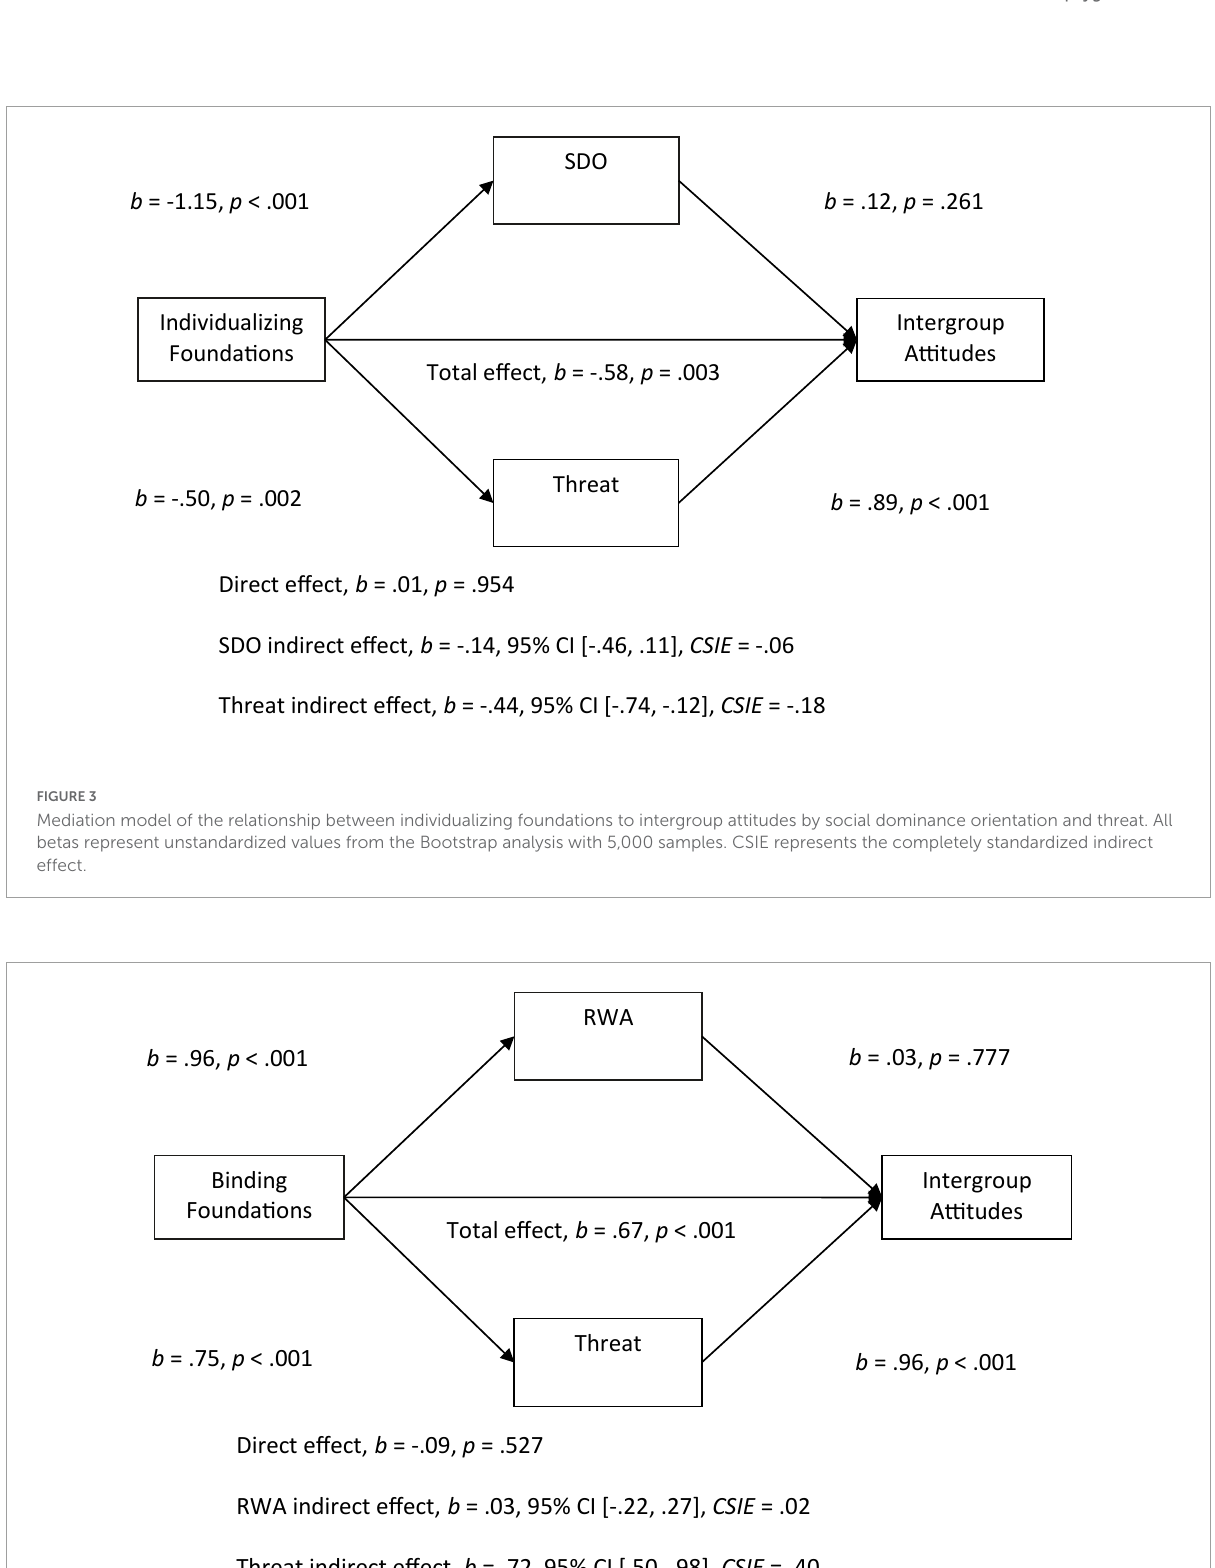
FIGURE4 Mediation model of the relationship between binding foundations to intergroup attitudes by right-wing authoritarianism (RWA) and threat. All betas represent unstandardized values from the Bootstrap analysis with 5,000 samples. CSIE represents the completely standardized indirect